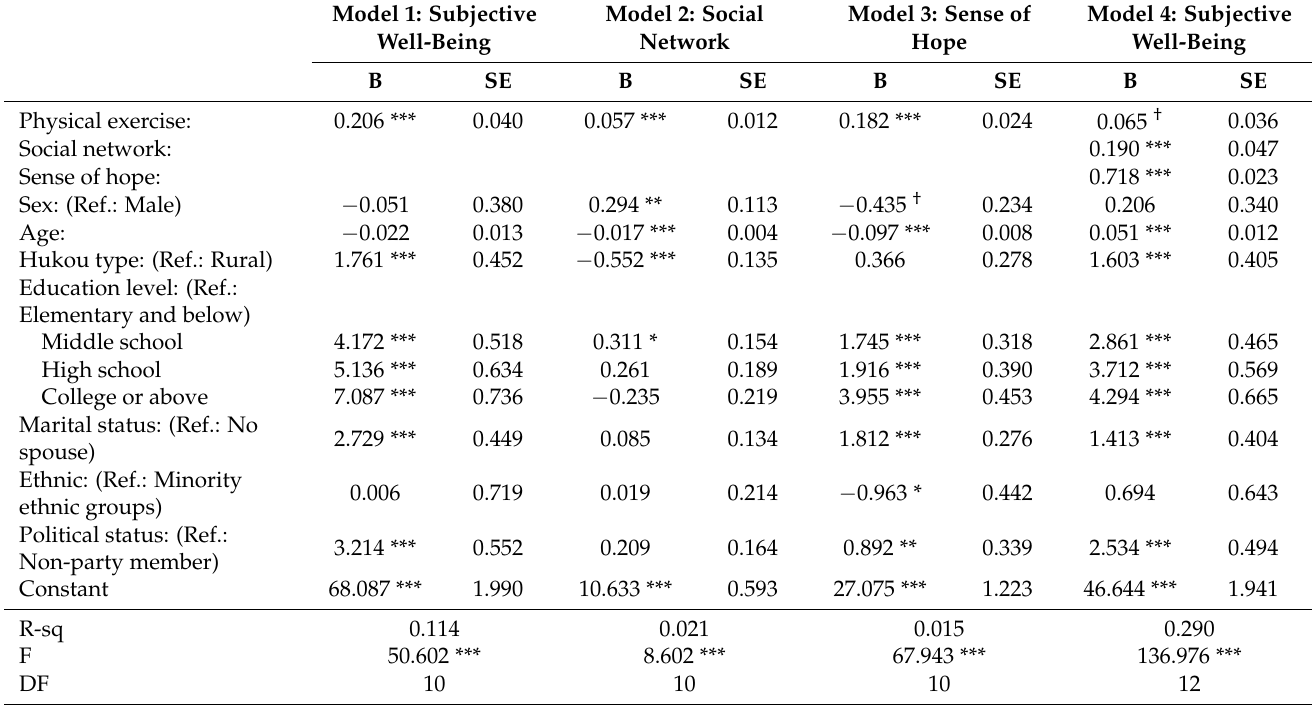
Table 4. Results of mediating-effect model (N = 4031).